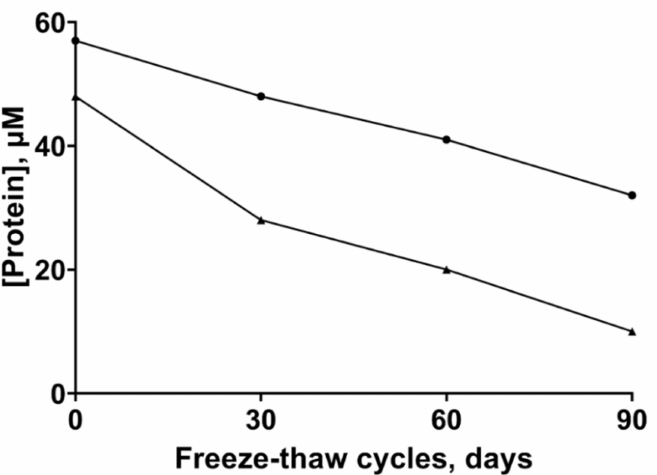
Figure 1. ZnT8c protein stability. Both ZnT8cR (circles) and ZnT8cW (triangles) were stored at − 20 ◦ C in 50 mM TRIS/HCl, pH 8, 500 mM NaCl, 300 mM imidazole, 2 mM DTT (dithiothreitol), 100 mM sucrose with 50% ( v / v ) glycerol. After each of three freeze–thaw cycles the concentration of soluble protein was determined